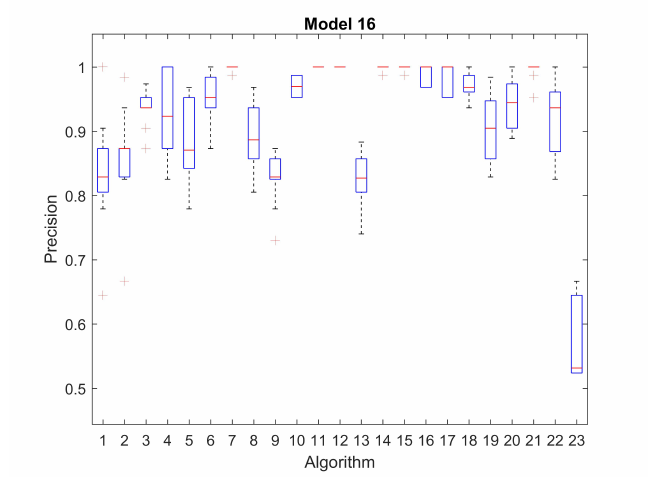
Figure A11. Precision of Model 16 for the different algorithms. The 23 algorithms are represented in the x -axis, and the accuracy is shown in the y -axis.